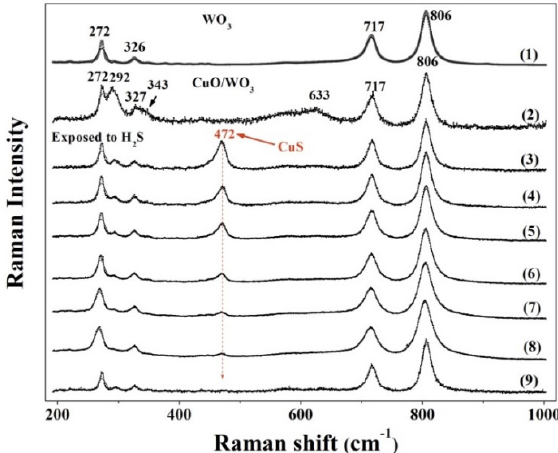
Figure 8. Raman spectra of the WO 3 sensor (1) and CuO / WO 3 (1:1) sensor (2) measured by 2 mW laser radiation exposed to air. The CuO / WO 3 (1:1) sensor is exposed to H 2 S gas after being irradiated by the laser with di ff erent energies: (3) 2 mW, (4) 4 mW, (5) 6 mW, (6) 8 mW, (7) 10 mW, (8) 12 mW, and (9) 14 mW.